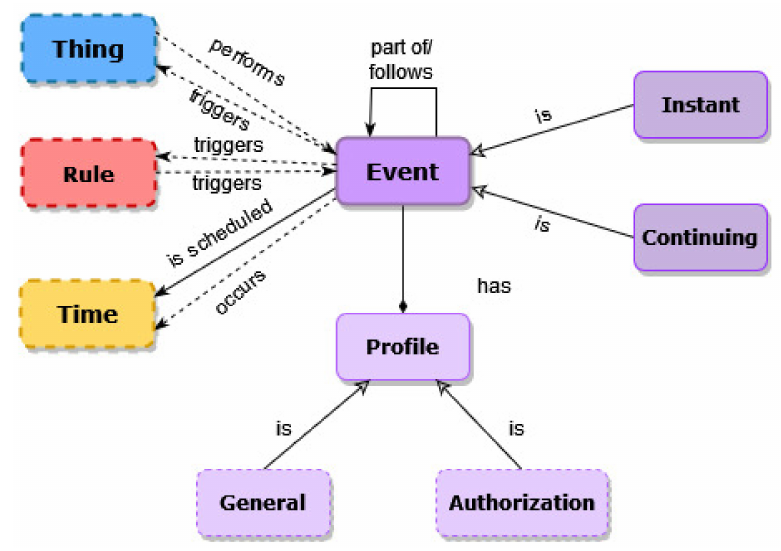
Figure 10. Event